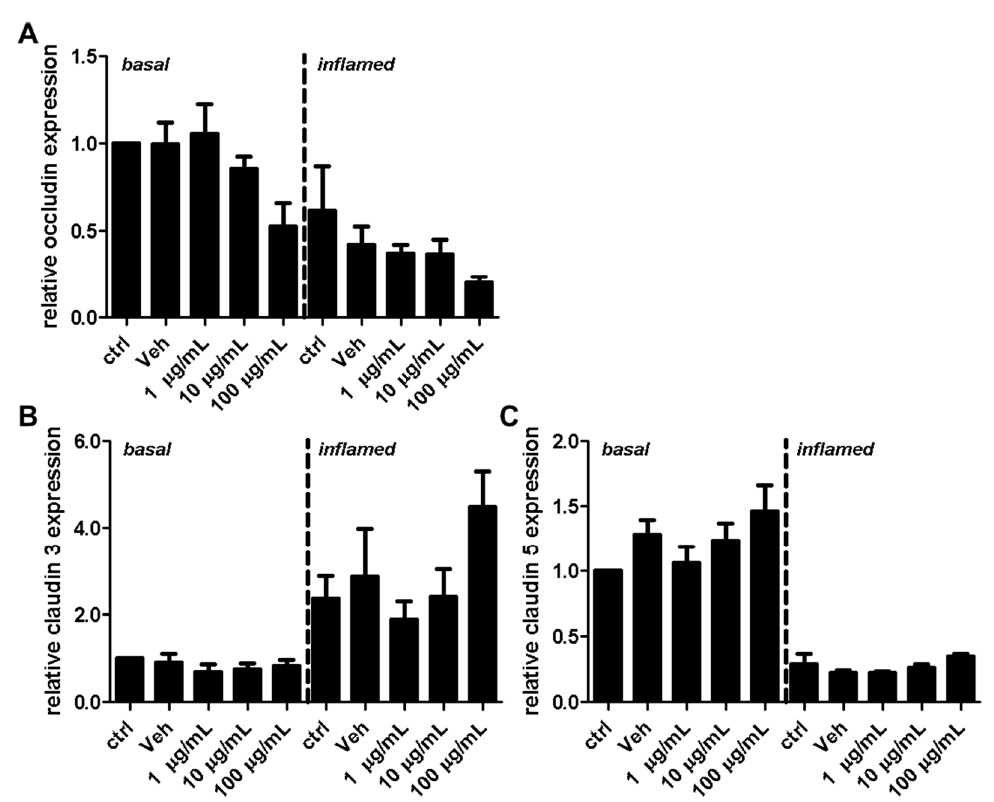
Figure 7. Effect of fullerenols on the relative gene expression levels of tight junctions of mouse brain microvascular endothelial cell (MBMEC) cultures under basal and inflammatory conditions. Real time PCR analysis of the expression levels of occludin ( A ), claudin 3 ( B ), and claudin 5 ( C ) in MBMEC after exposure to interferon- γ and tumor necrosis factor- α (inflamed; I + T; 100 IU each) and treatment with fullerenol (F; 1, 10 and 100 µg/mL; n = 3 − 4) for 18 h compared to cultures under basal (homeostatic milieu) conditions. GAPDH was used as a housekeeping gene. Ctrl, untreated control; Veh, vehicle treatment.